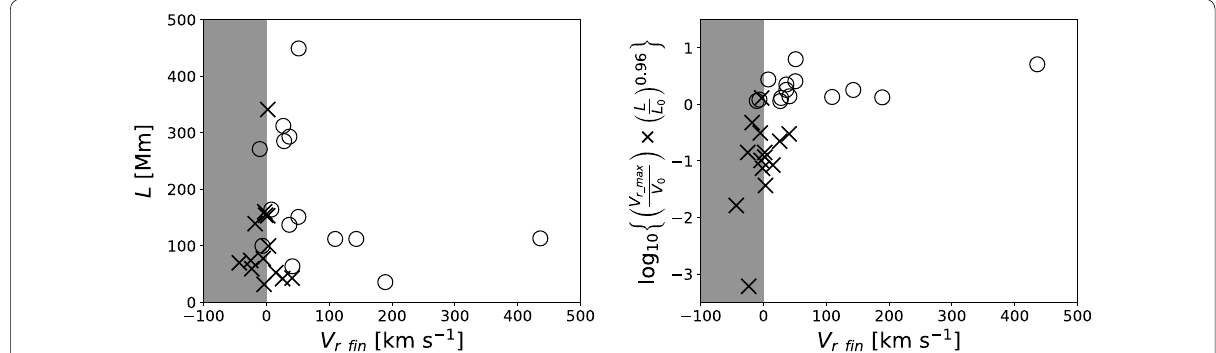
Fig. 3 Plot of filament eruptions according to V r_fin and L (left) or common log of the product of normalised V r_max and normalised L to the power of 0.92 (right). Open circles and crosses have the same meaning as in Fig. 1. Grey area corresponds to negative V r_fin